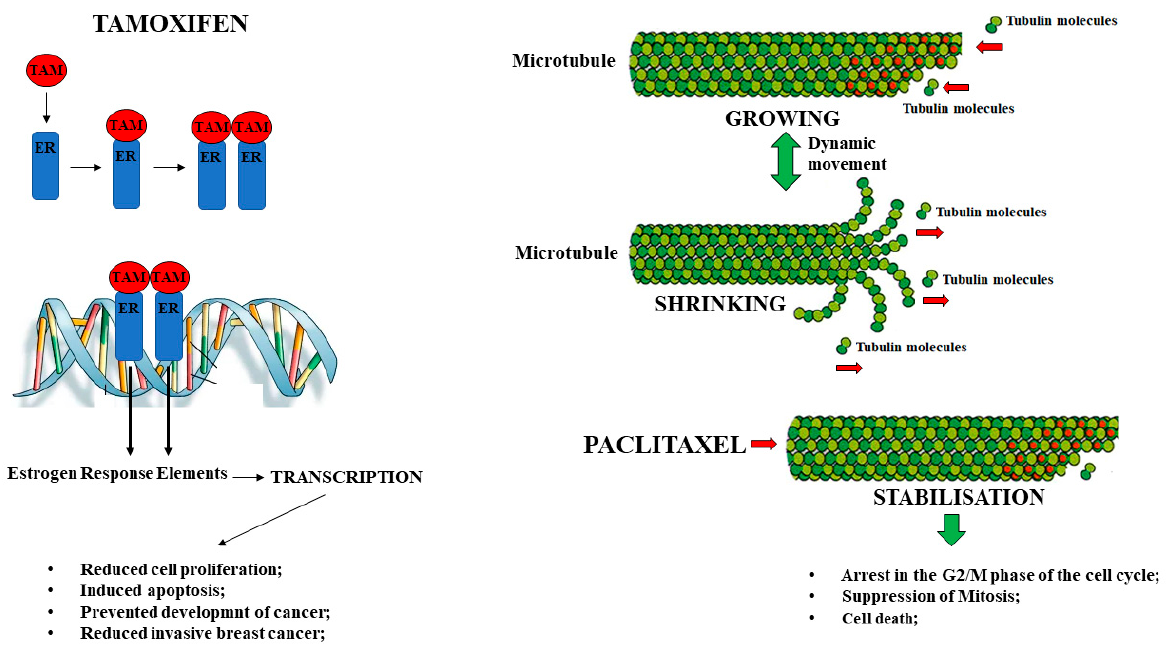
Figure 3. Mechanism of action of Tamoxifen and